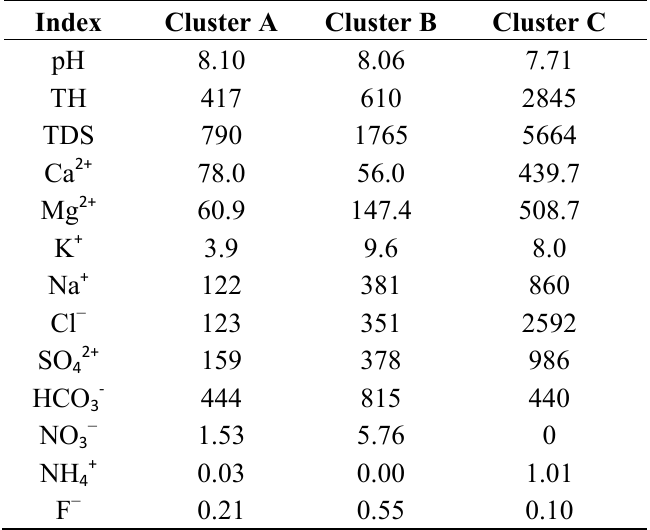
Note: Units: mg/L (except for